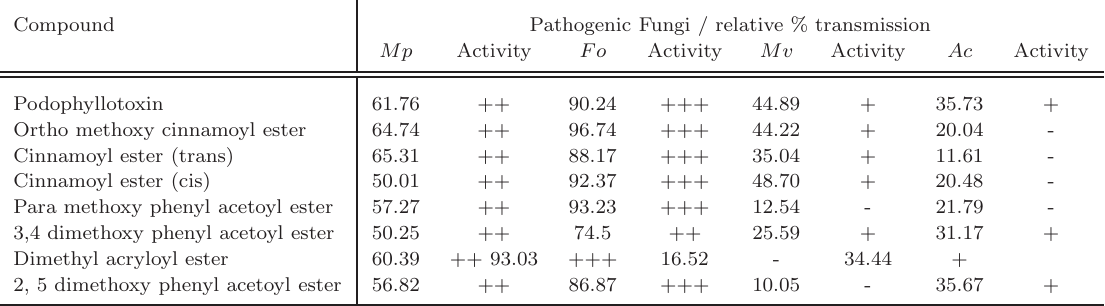
Table 2 Fungicidal activity of the ester derivatives of podophyllotoxin.